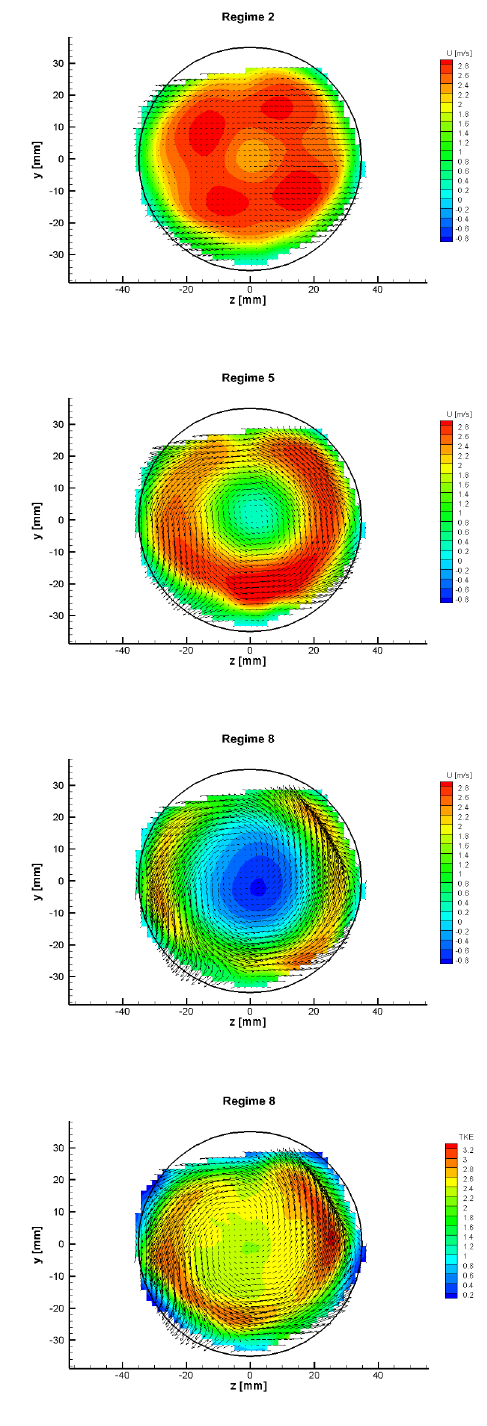
Fig. 3a, b, c, d. Cross-sectional planes, distribution of streamwise velocity component (a, b, c) and TKE (d)